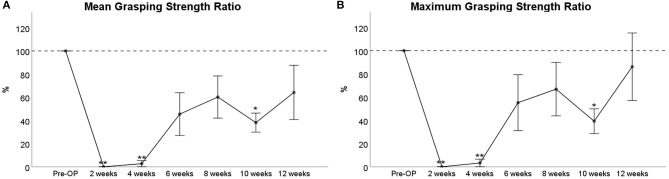
Assessment of mean (A) and maximum (B) grasping strength following 7-mm median nerve resection and autograft repair. Note the reduced number of animals (n = 6) that could be included for statistical testing by means of repeated measures ANOVA (RMANOVA). This was due to reduced motivation to participate in the testing procedure. *p < 0.05 as compared to Pre-OP, **p < 0.01 as compared to Pre-OP.